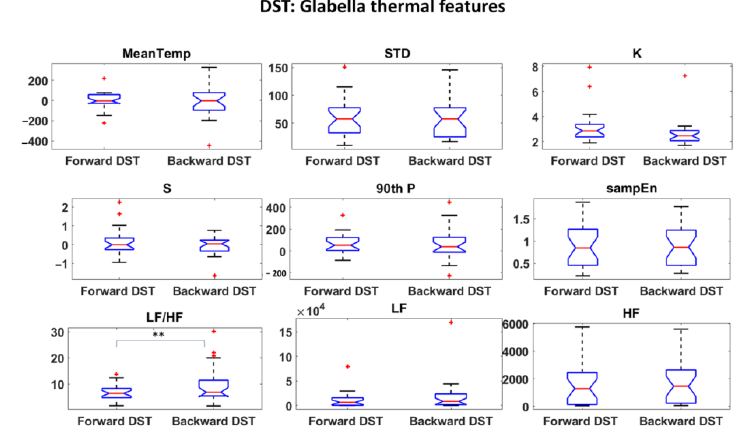
Figure 7. Thermal features relative to Glabella ROI extracted during DST (** p < 0.01). Outliers are represented with red crosses. The titles of the single plots refer to abbreviations of features described in Section 3.3.